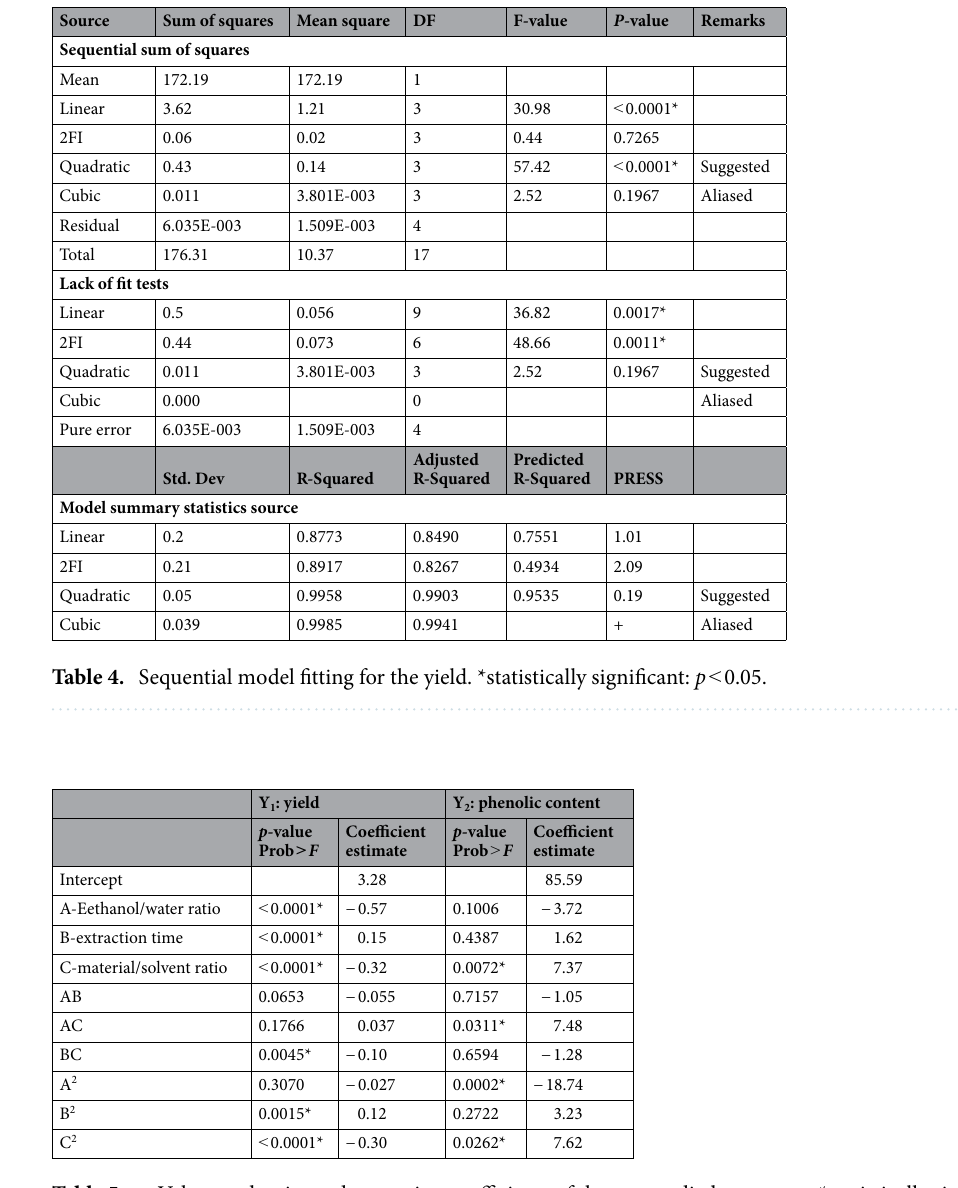
Table 5. p -Values and estimated regression coefficients of the two studied responses. *statistically significant: p ˂ 0.05.